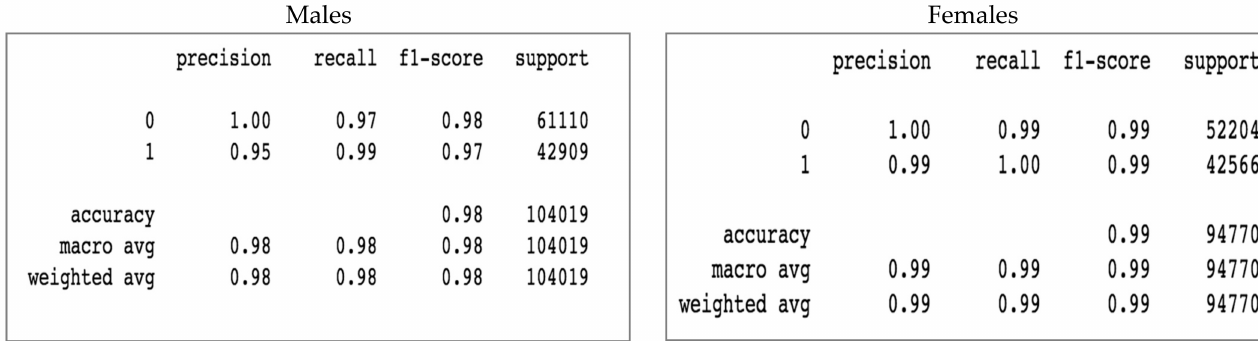
Figure 13. Classification report for VGG16’s experiment